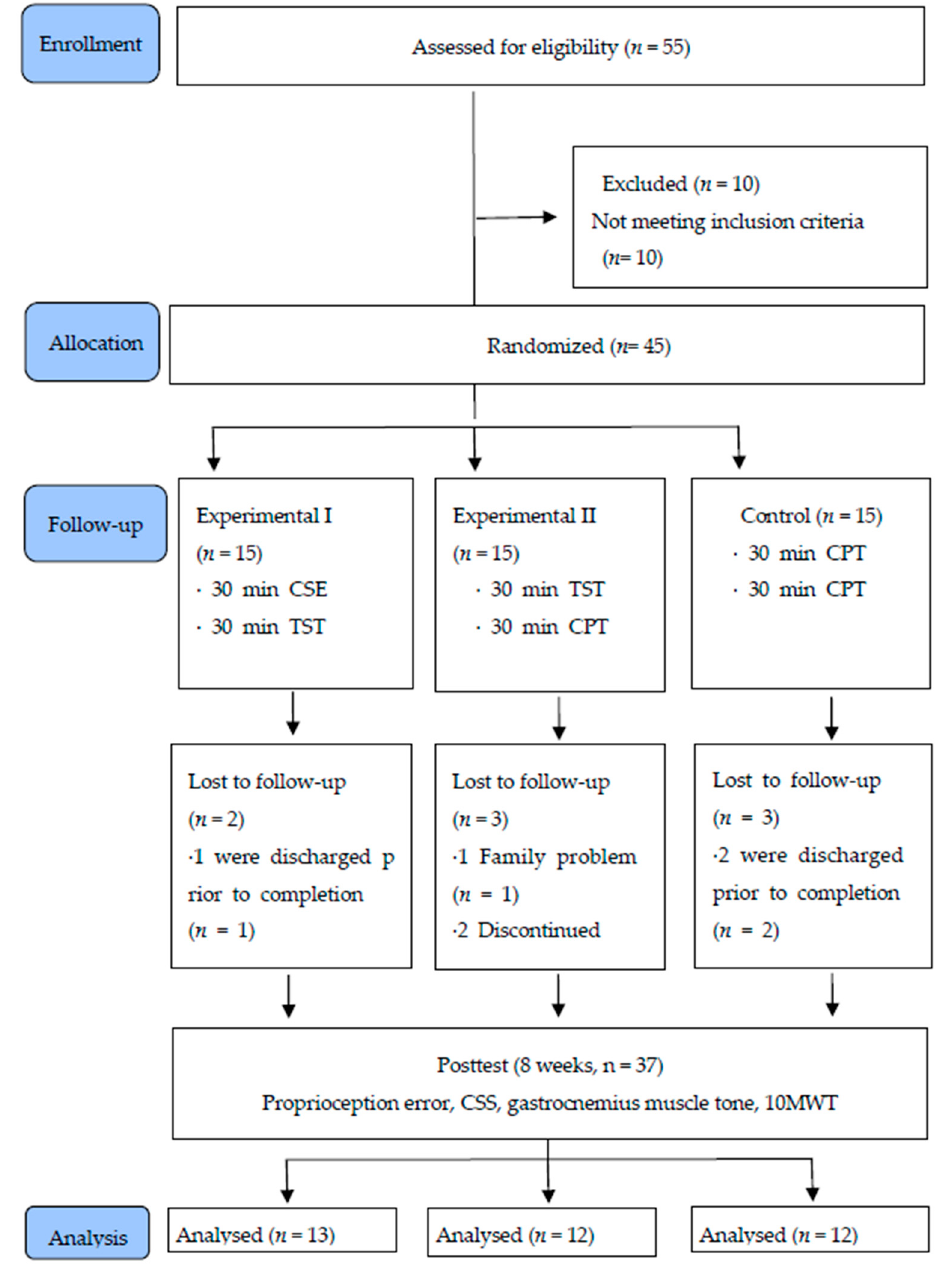
Figure 2. Flow diagram of the study.